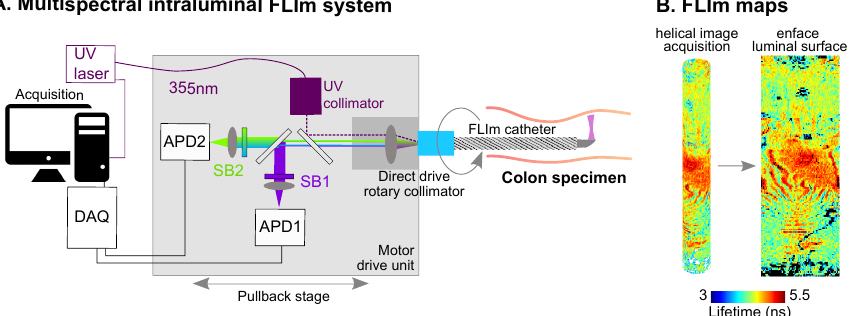
Figure 6. ( A ) Two-channel, APD-based intraluminal FLIm instrument. ( B ) Representative fluo- rescence lifetime map of a mice colon acquired intraluminally and flattened image as shown in subsequent figures. UV: ultraviolet; APD: avalanche photodiode; SB: spectral band; DAQ: data acquisition